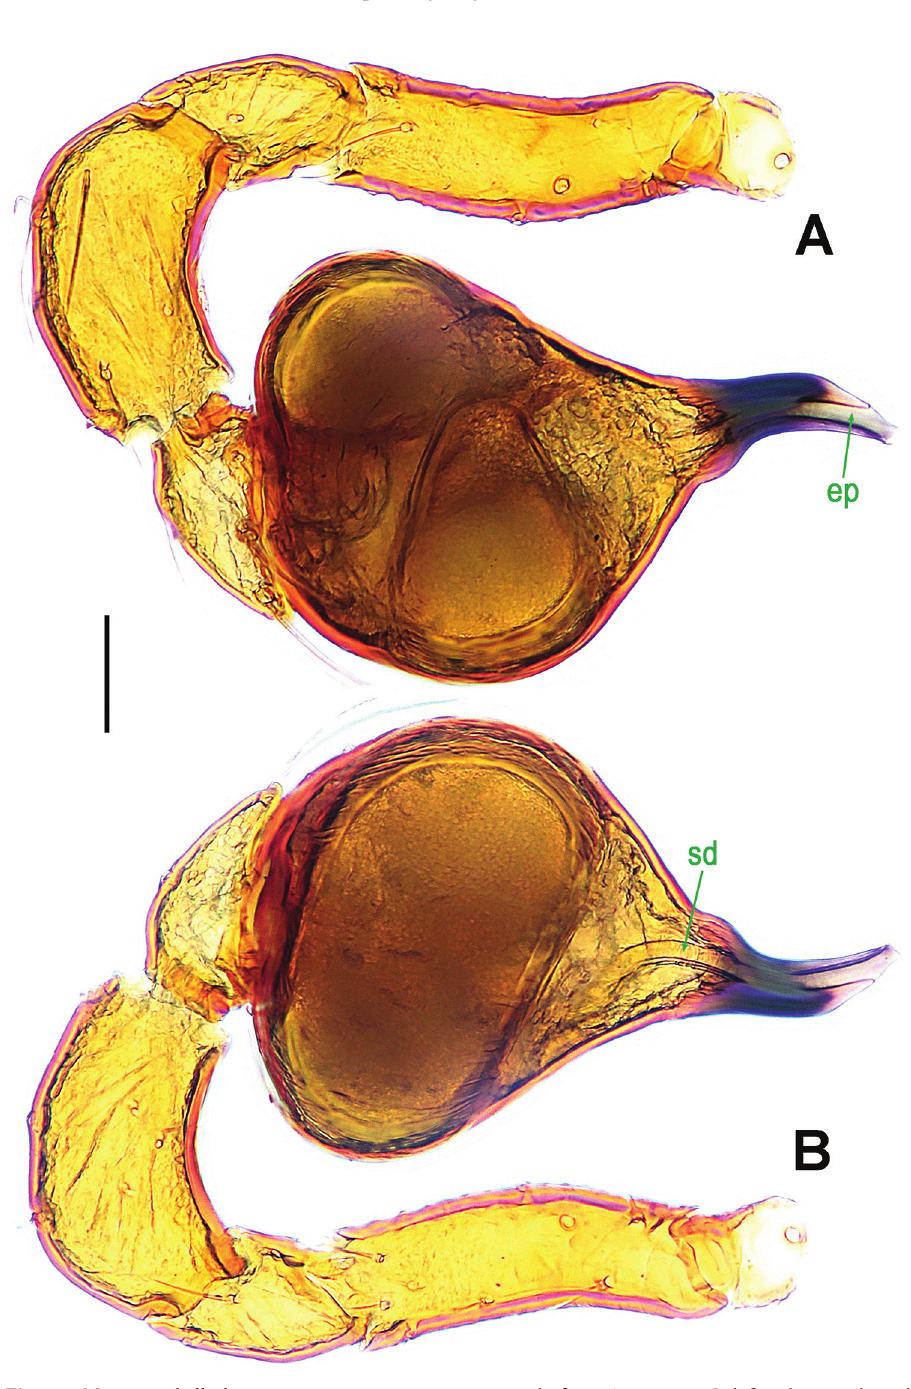
Figure 11. Brignoliella besutensis Lin, Li & Jäger, 2012, male from Singapore. A left palp, retrolateral B ditto , prolateral. Abbreviations: ep = embolic part of apes of palpal organ; sd = spermatic duct. Scale bars: 0.10